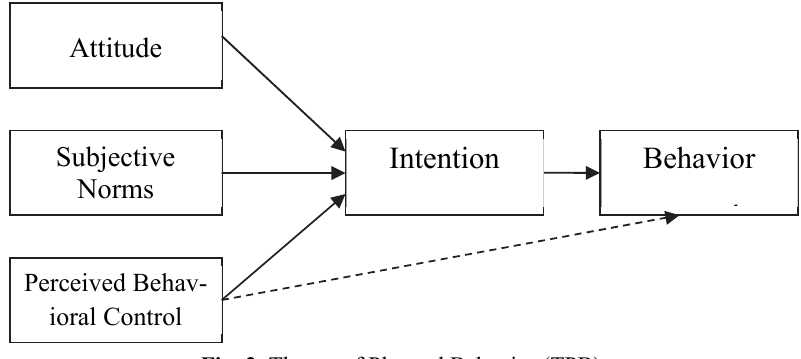
Fig. 2. Theory of Planned Behavior